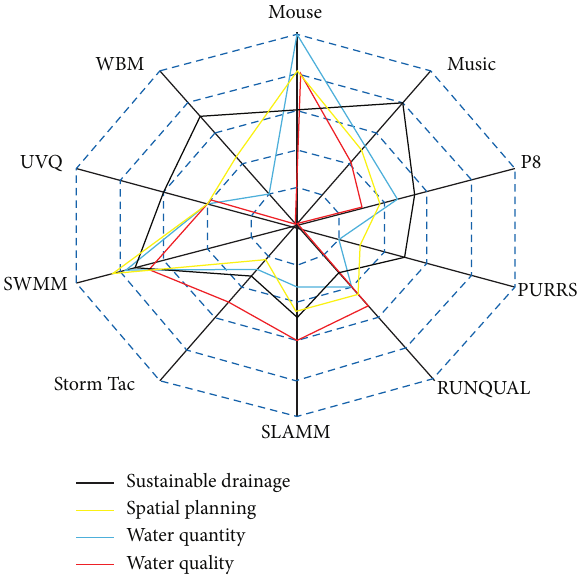
Figure 6: Use of several hydrological models for quality and amount of water, spatial planning, and sustainability of drainage (redrawn from